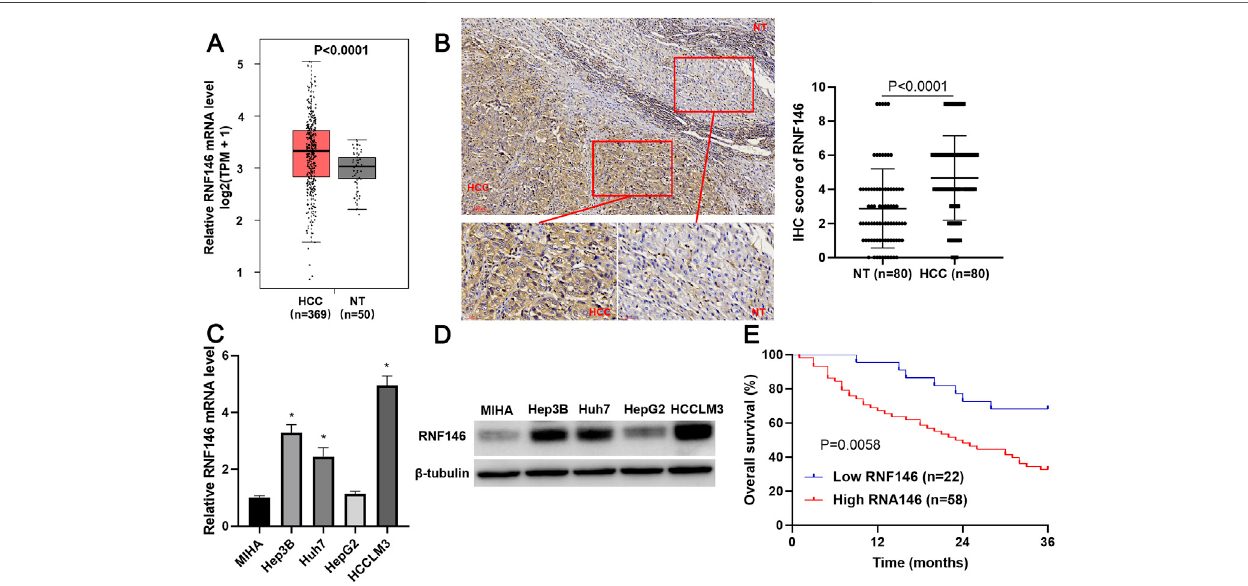
FIGURE 2 | RNF146 expression is increased in HCC. (A) TCGA data analysis using the GEPIA platform showed the expression difference of RNF146 mRNA between HCC and normal liver tissues. (B) IHC analysis indicated that RNF146 was highly expressed in HCC compared to adjacent nontumor tissues. (C) The RNF146 mRNA levels were detected in MIHA, Hep3B, Huh7, HepG2 and HCCLM3 cells by RT-qPCR. (D) The RNF146 protein levels were detected in MIHA, Hep3B, Huh7, HepG2 and HCCLM3 cells by WB. (E) The comparison of 3-years overall survival of patients with high or low RNF146 expression.